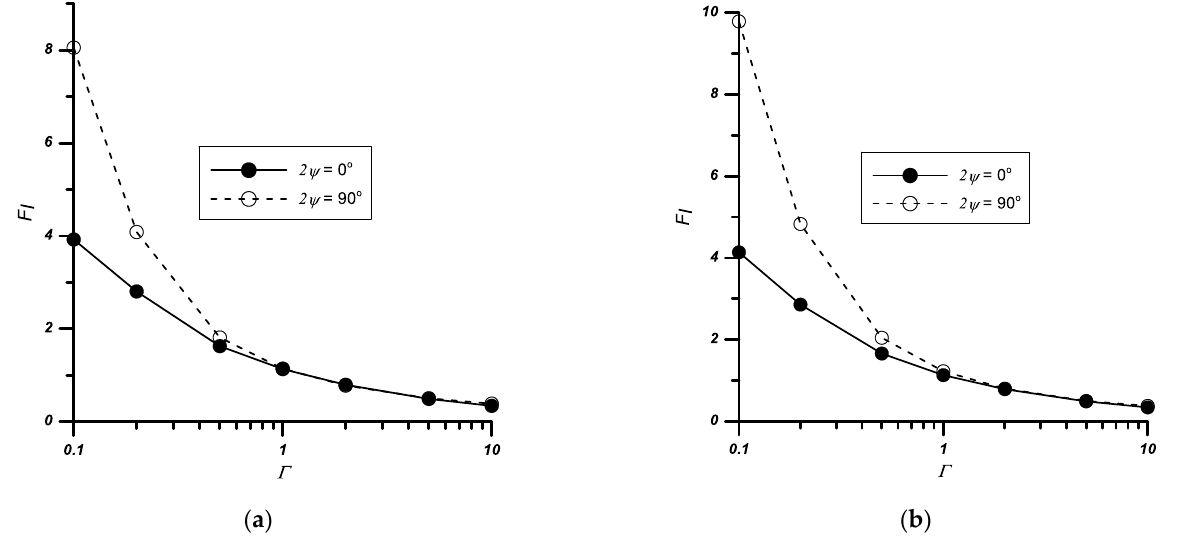
Figure 8. Variation of the normalised stress intensity factors F I with the relative stiffness Г and the notch angle 2 ψ , ( a ) σ x / σ y 1 = 1, ( b ) σ x / σ y 1 = 0.5, a/w = 0.4.